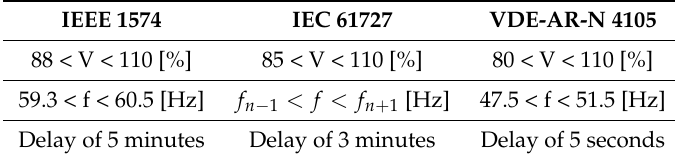
Table A7. Reconnection requirements.